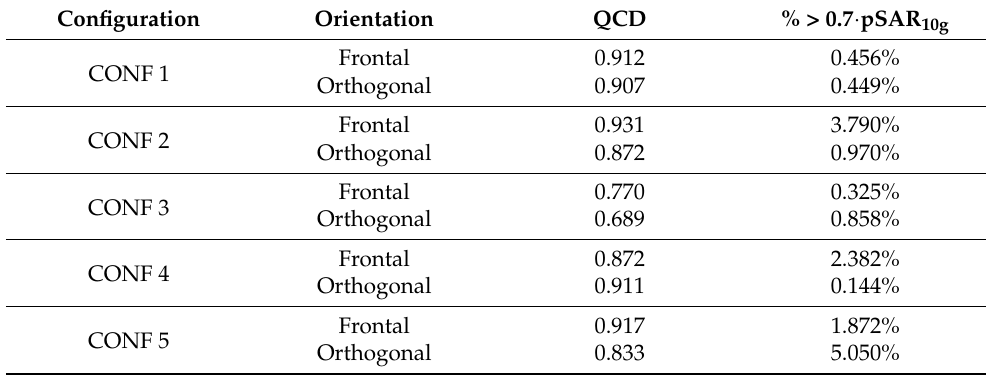
Table 2. pSAR 10g of each configuration for the skin of the head.